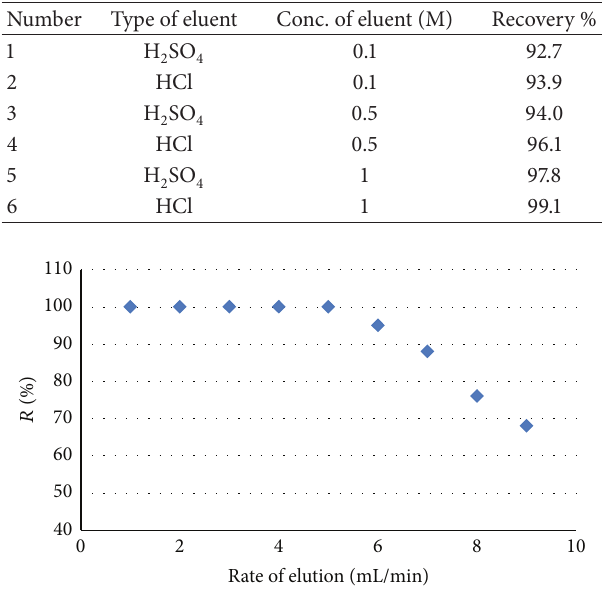
Figure 2: Effect of elution rate of column on the preconcentration of arsenic from drinking water sample; pH = 6, 20 𝜇 g/L of arsenic, and eluent of HCl